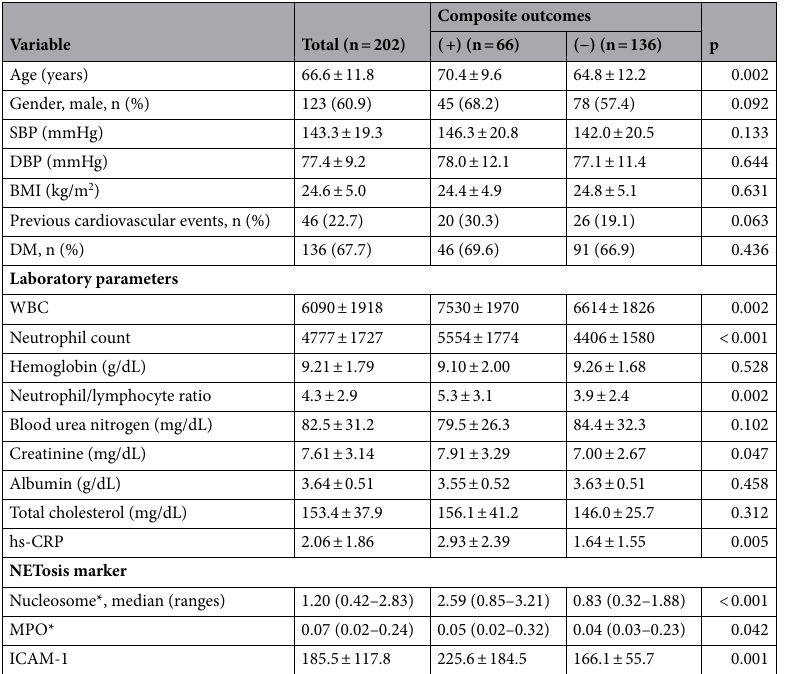
Table 1. Baseline clinical and biochemical data according to the occurrence of composite outcomes. Data are expressed as means ± SD except for those with *, which are medians with